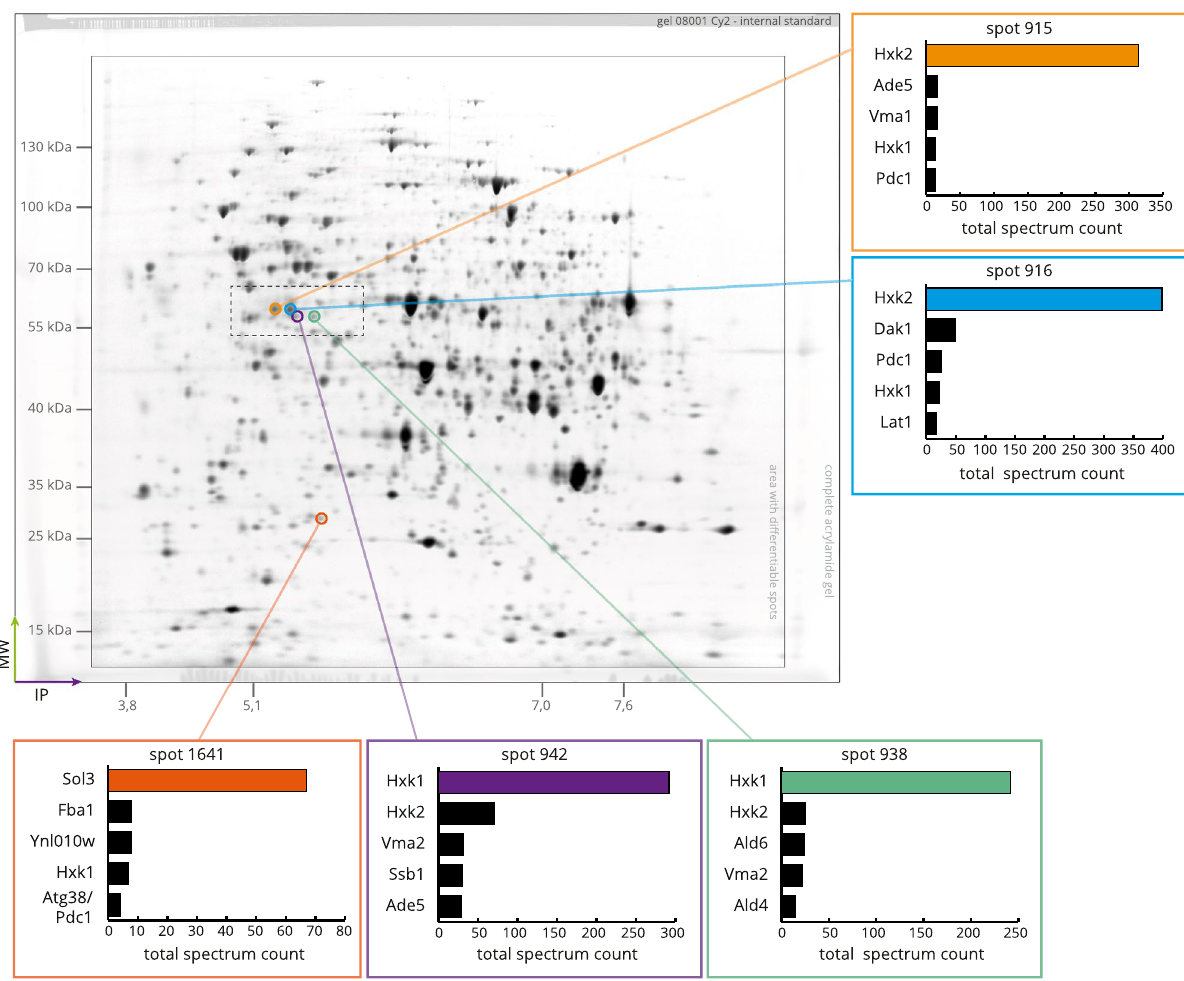
Figure 1. Identification of TDA1 -dependent proteins by comparison of BY4742 wild type and ∆ tda1 deletion mutant proteomes employing 2D-DIGE. 50 µg of the Cy2 labeled internal standard were separated via 2D-DIGE. The Cy2-channel of the fluorescence scan is shown in the full size of the gel. For each TDA1 - dependent spot, samples were excised from preparative 2D-gels and, in a blinded experiment, analyzed via LC/ ESI–MS/MS. The total spectrum counts from two analyses (separate gels, separate MS runs) were summed for each spot, excluding protein identities only found once. For five spots, the five protein species with the highest spectrum count are depicted in the diagrams. The colored bars in the diagrams indicate the proteins determining the spot identity. The dotted rectangle represents the area that was enlarged for supplementary Fig. S1. Note that the presented gel image was edited for illustrative purposes, and only the area containing the separated proteins is presented with optimized contrast. For the raw image data, see the supplements online at DOI: https:// doi. org/ 10. 17605/ OSF. IO/ could not unequivocally be narrowed down to one protein. Spots 913 and 944 showed a separate maximum and were identified as individual spots, but they were very closely located to spot 915, which was identified as Hxk2. Spot 945 exhibited high spectrum counts for Vma2 but Djp1 also. Supplementary Fig. S1 shows the position of TDA1-dependent spots with ambiguity regarding spot identity. The full dataset of spot identifications is available in the supplements online at DOI: https:// doi. org/ 10. 17605/ OSF. IO/ 7AEQC. The hexokinases Hxk1 and Hxk2 were each found in more than one spot. The different isoelectric points, despite the similar molecular weight of these spots, suggested posttranslational modifications to be present, of which a phosphorylation appeared to be very likely. In the following, the designation of hexokinases as phospho- rylated or unphosphorylated refers to the phosphorylation of serine 15 specifically, unless indicated otherwise. Upon TDA1 deletion, the volume of spot 915 and thus the quantity of phosphorylated Hxk2 decreased drasti- cally while that of spot 916, unphosphorylated Hxk2, increased. Analogously, the same observation was made regarding Hxk1. Spots with phosphorylated Hxk1 decreased in spot volume, whereas those with unphosphoryl- ated Hxk1 increased. While the amount of Sol3 more than doubled, the spots with Vma2 and Djp1 exhibited a decreased spot volume. A visual comparison contrasting the fold change, p-value and spot volume of the TDA1 -dependent spots and all the other observed spots is available in the supplementary Fig. S2. The predicted